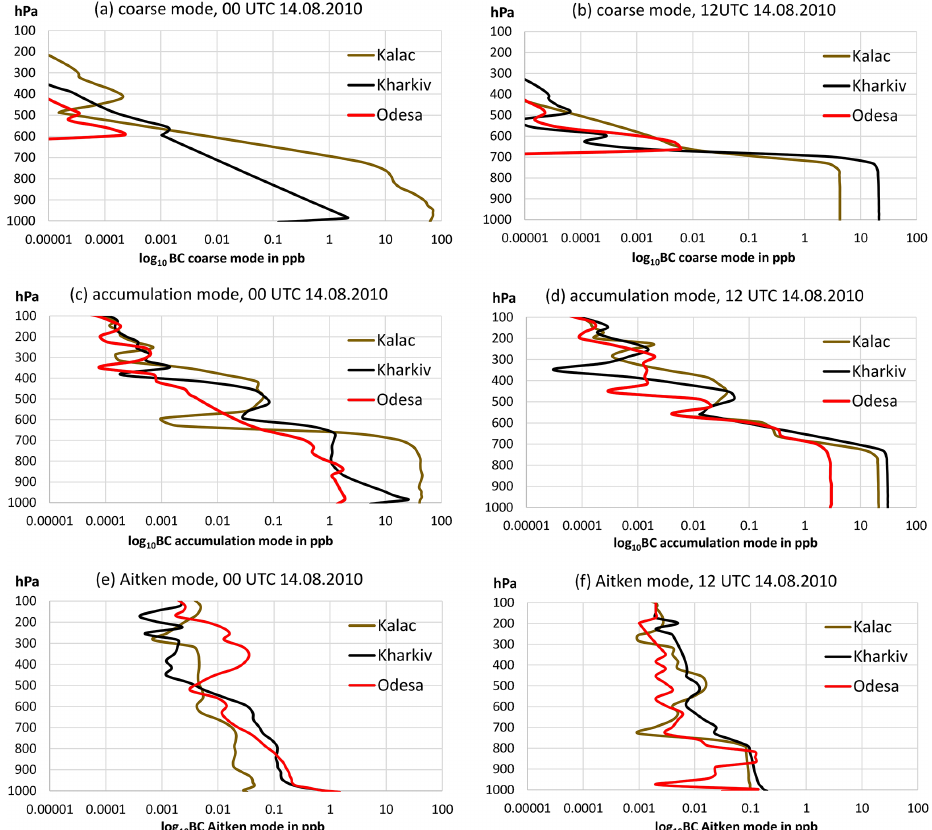
Figure 5. The vertical profiles of BC for the coarse (a, b) , accumulation (c, d) , and Aitken (e, f) modes at the Kalac, Kharkiv, and Odesa sounding stations, as examples, at 00:00UTC (a, c, e) and 12:00UTC (b, d, f) on 14 August 2010 (log 10 , x axis selected for better visibility and